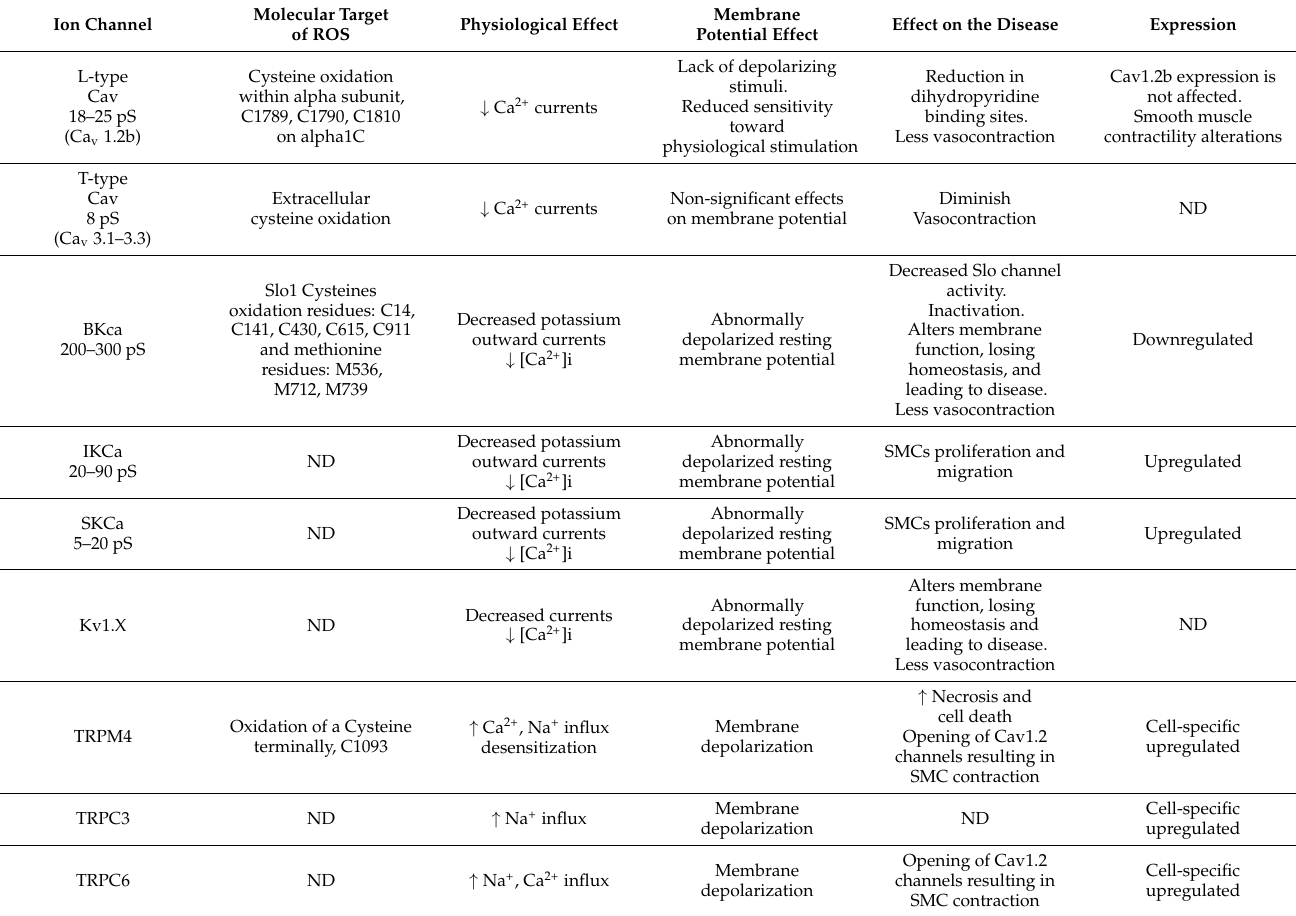
Table 1. Oxidation changes in ion channels and their effect on